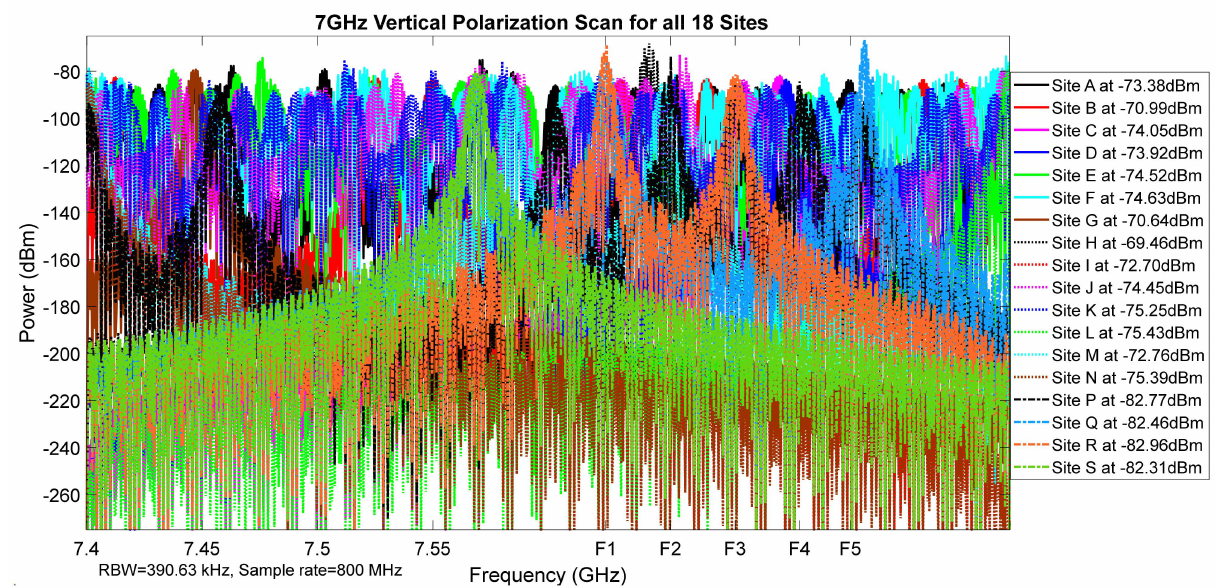
Figure 44. The 7 GHz vertical polarization scan for all sites after denoising and applying the algorithm to all sites, including those without the potential to cause interference.